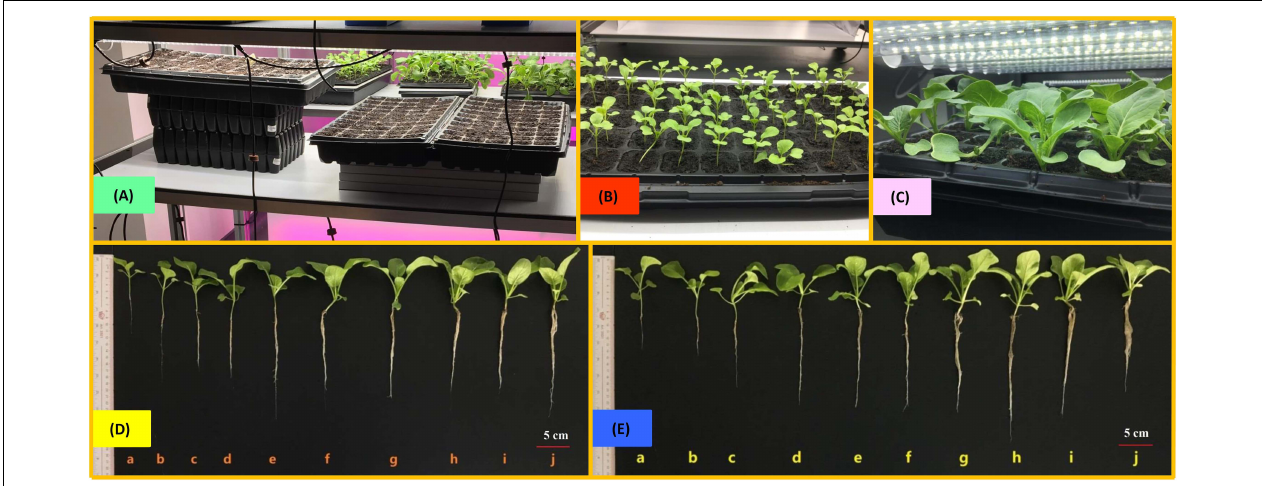
FIGURE 1 | The pictures to show (A) the setting in this study, choy sum seedling grown (B) under low light intensity [50–150 µ mol/(m 2 · s)] on day 14 and (C) under high light intensity [400–500 µ mol/(m 2 · s)] on day 14 in the germination trays, as well as the morphologies of the representative choy sum seedlings grown under different white light emitting diode (LED) light intensities on (D) Day 14 and (E) Day 16, respectively (the transplantation days). Choy sum seedling grown under (a) 50 µ mol/(m 2 · s); (b) 100 µ mol/(m 2 · s); (c) 150 µ mol/(m 2 · s); (d) 200 µ mol/(m 2 · s); (e) 250 µ mol/(m 2 · s); (f) 300 µ mol/(m 2 · s); (g) 350 µ mol/(m 2 · s); (h) 400 µ mol/(m 2 · s); (i) 450 µ mol/(m 2 · s); and (j) 500 µ mol/(m 2 · s), respectively. The criterion for the representative seedlings to be presented in the singular photos of panels (D,E) were based on their average morphological data ( Figure 4 ) under their respective light conditions.